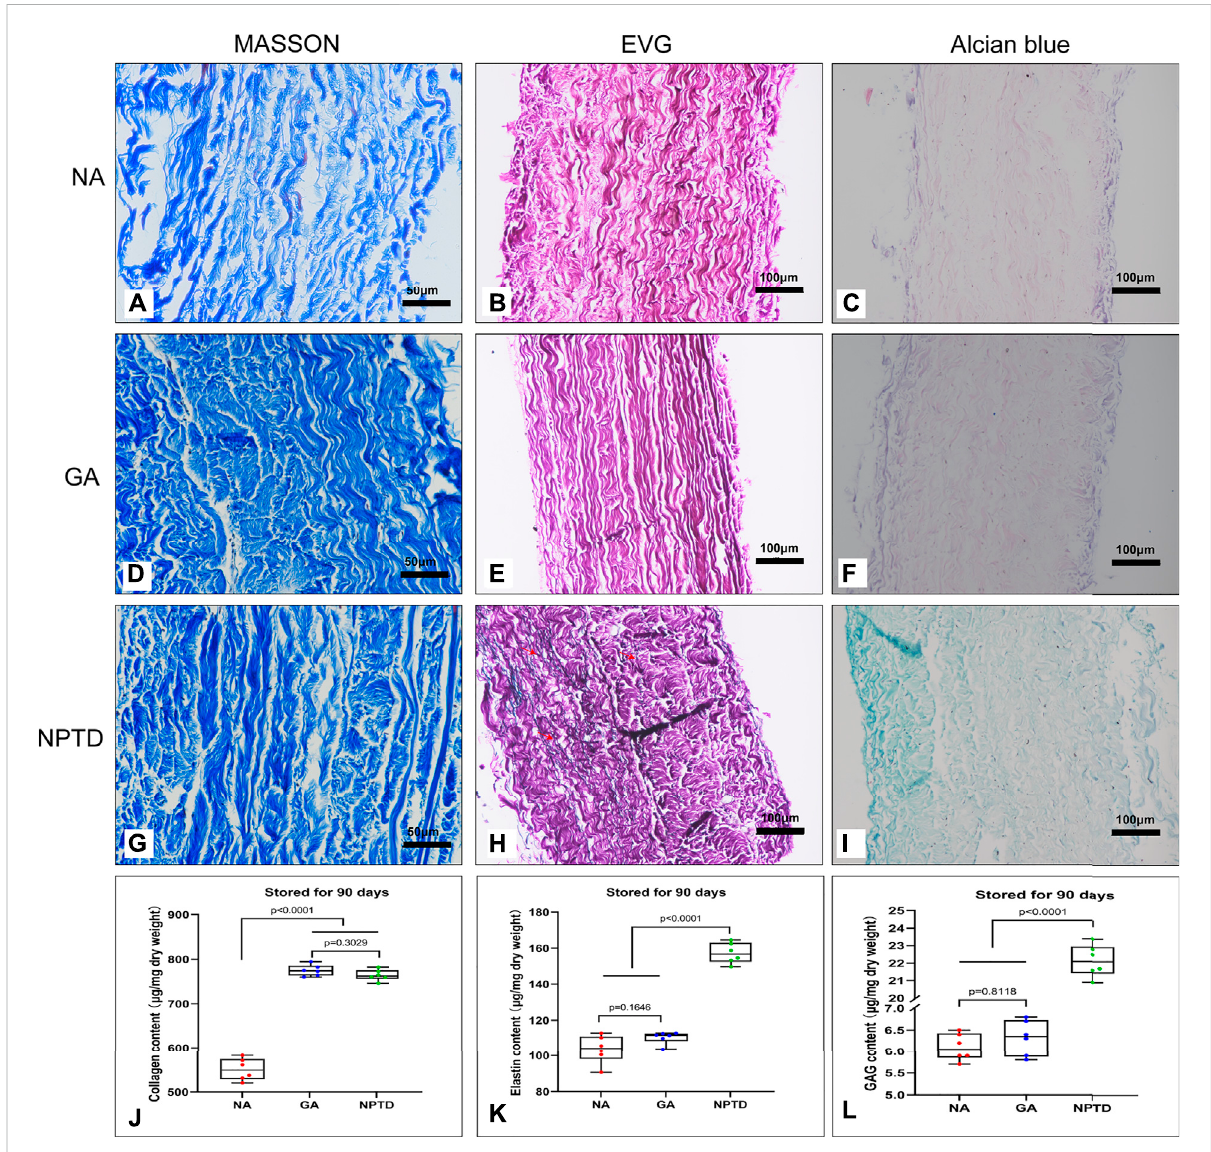
FIGURE 7 The stability of the pericardium after 90 days of storage in vitro . The images show the Masson ’ s trichrome staining (A,D,G) , elastic Van-Gieson staining (B,E,H) and Alcian blue staining (C,F,I) . Red arrows show preserved elastic fi bers in the NPTD group. The residual content of collagen in the GA and NPTD groups was signi fi cantly higher than that in the NA group (J) . The residual content of elastin and GAGs in the NPTD groups was signi fi cantly higher than that in the NA and GA group (K,L) . Statistical analysis was performed by one-way analysis of variance